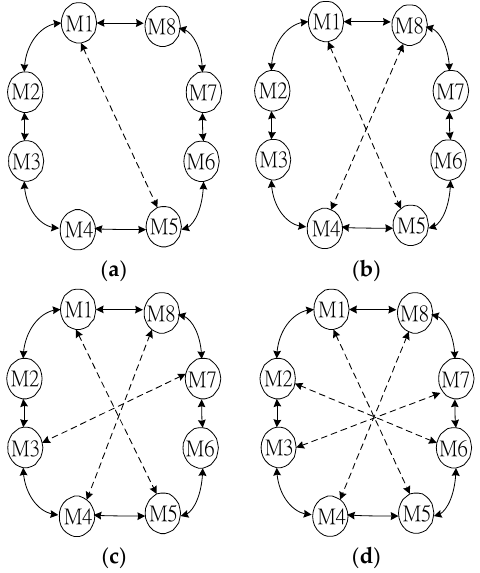
Figure 4. The possible mesh link connection example for each master in a scatternet: ( a ) The first mesh link connection; ( b ) The second mesh link connection; ( c ) The third mesh link connection; ( d ) The fourth mesh link connection.